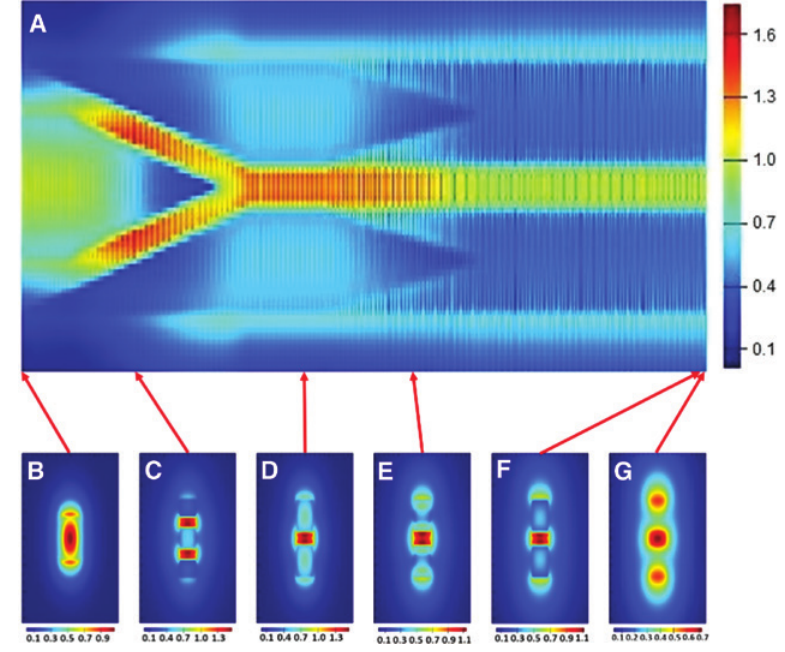
Figure 3: Simulation results for strip-to-SWGS mode converter. (A) Simulated top view of electric field distribution of the strip-to-SWGS mode converter and (B–E) cross-section view of mode evolution. (B) Strip waveguide region. (C) Middle of the strip-to-slot mode converter. (D) Slot waveguide region. (E) Middle of the slot-to-SWGS mode converter. (F) Si segment of SWGS waveguide. (G) SiO segment of SWGS 2